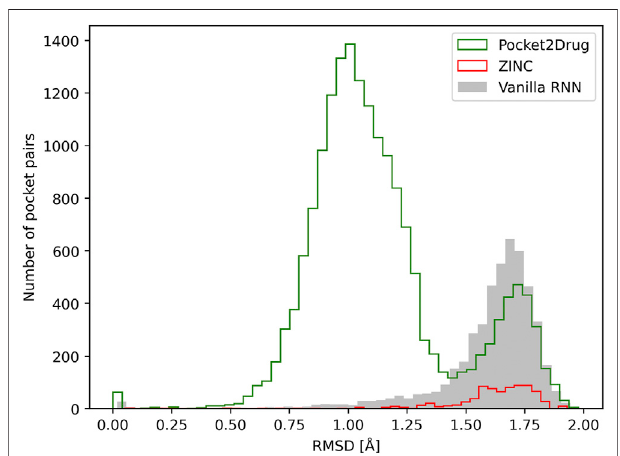
FIGURE8| Assessment ofthequalityofpocketalignmentsconstructed with PocketAlign. Alignment quality is evaluated by the root-mean-square deviation (RMSD) calculated over non-hydrogen atoms of binding residues. Target pockets are aligned to binding sites identi fi ed in the Protein Data Bank for molecules generated by Pocket2Drug (green) and two baselines, ZINC (red) and vanilla RNN (gray).